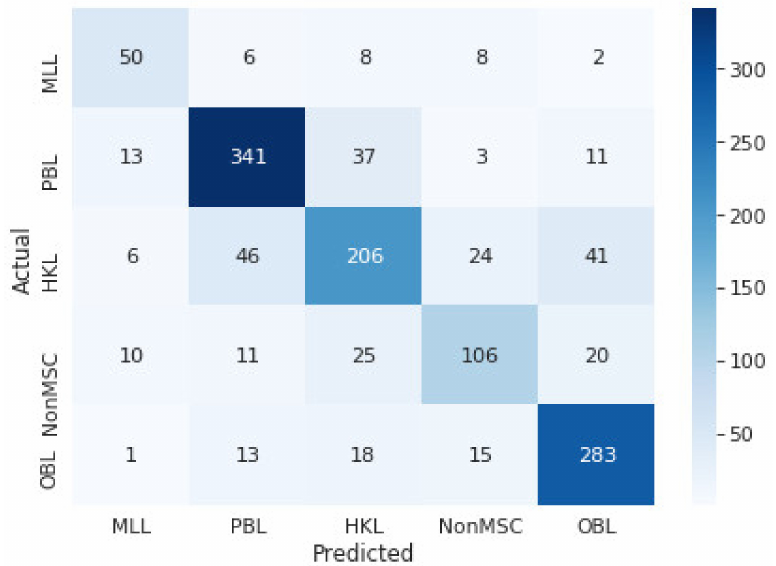
Figure 3. Confusion matrix of the validation set for MLL vs. PBL vs. HKL vs. NMSC vs. OBL.